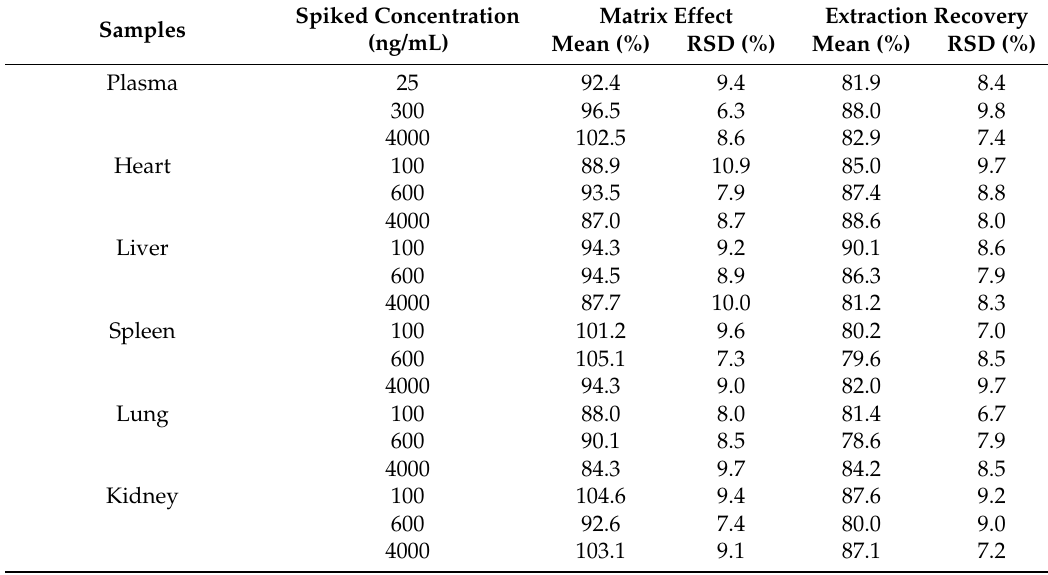
Table 3. Matrix effects and extraction recovery for the analytes in rat biological samples (n = 6). Spiked Samples